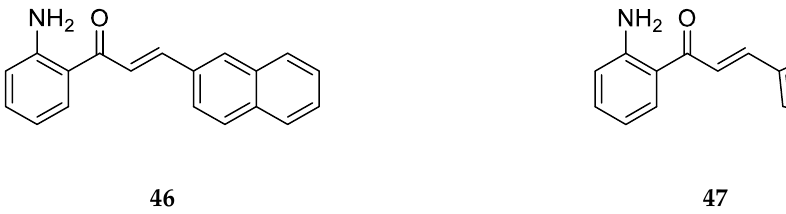
Figure 29. Chemical structures of 2-aminochalcone derivatives with substitution on ring B.